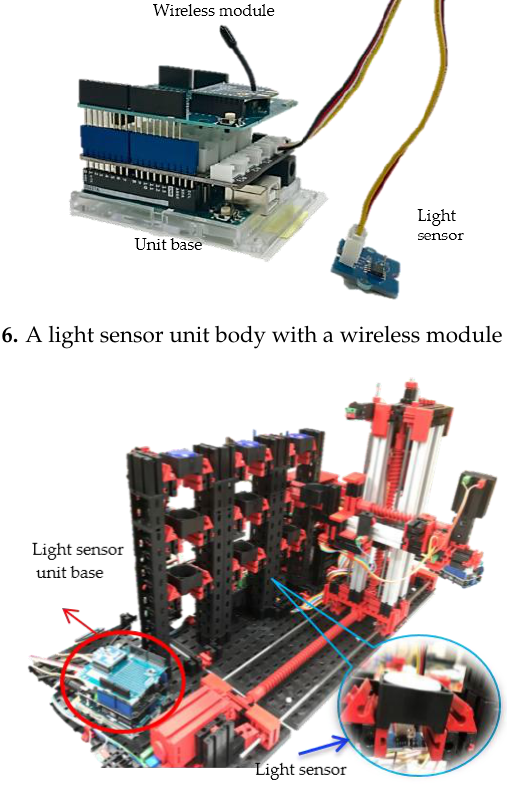
Figure 7. High-bay warehouse area with built-in light sensors.